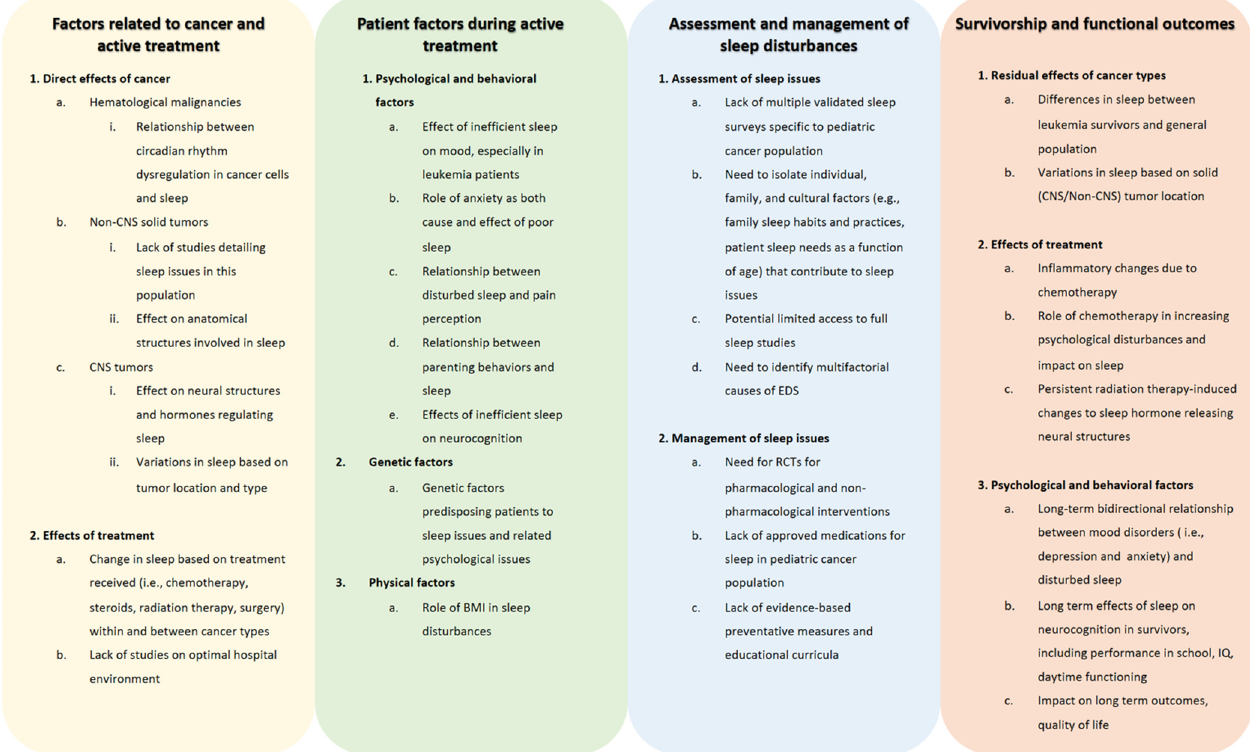
Figure 3. Gaps in knowledge on sleep disturbances in children with cancer. The figure describes areas where there is a need for further investigation in regard to sleep issues, their assessment and management, and their causes and sequalae during and after treatment, including many years into survivorship. Abbreviations: BMI, body mass index; CNS, central nervous system; EDS, excessive daytime sleepiness; IQ, intelligence quotient; RCT, randomized controlled trial.